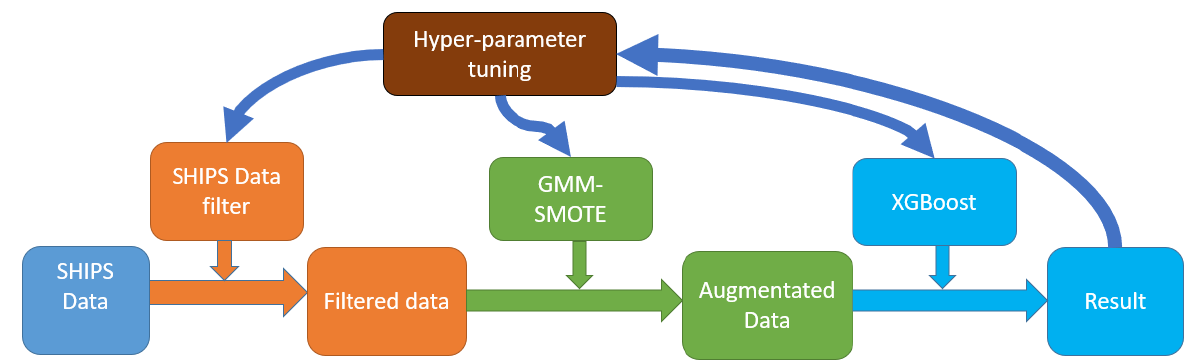
Figure 1. The structure of the artificial intelligence (AI) system.